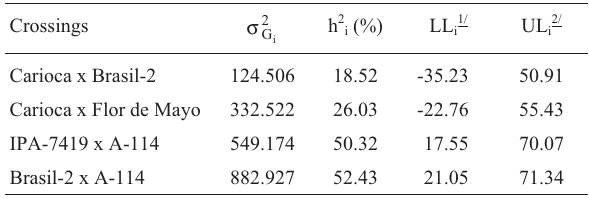
Table IV - Genetic variance ( σ G2 ) and broad sense heritability (h 2 i ) with 5:7 fami- i their respective confidence intervals, grain yield (g/plot) of F 5:7 lines from four common bean populations evaluated in Lavras-MG and Patos de Minas-MG, Brazil.